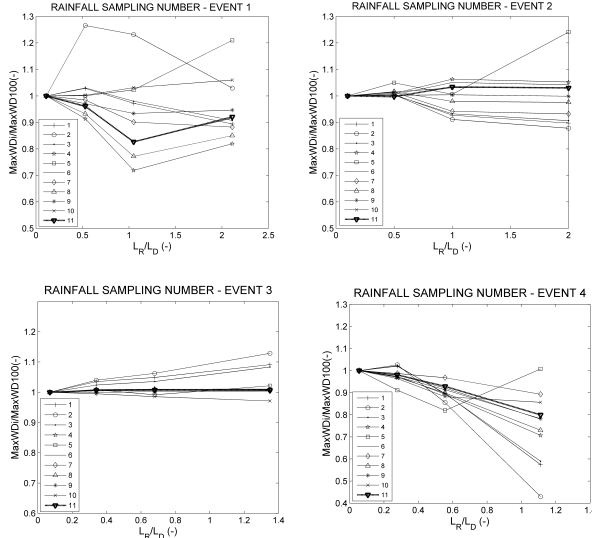
Figure 10. Normalised maximum in-sewer water depths versus rainfall sampling number ( L R / L D ) : results at the outlet of the 10 subcatchments (numbered 1 to 10) and of the whole catchment (no.